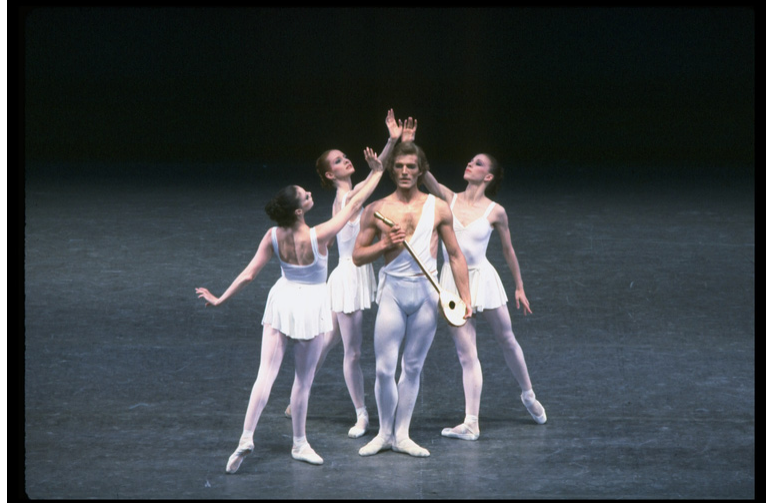
Figure 2. Balanchine’s Apollo in the NYCB, 1982. Dancers: Suzanne Farrell, Maria Calegari, Peter Martins, Kyra Nichols. Photo © Martha Swope and the New York Public Library, used with permission.